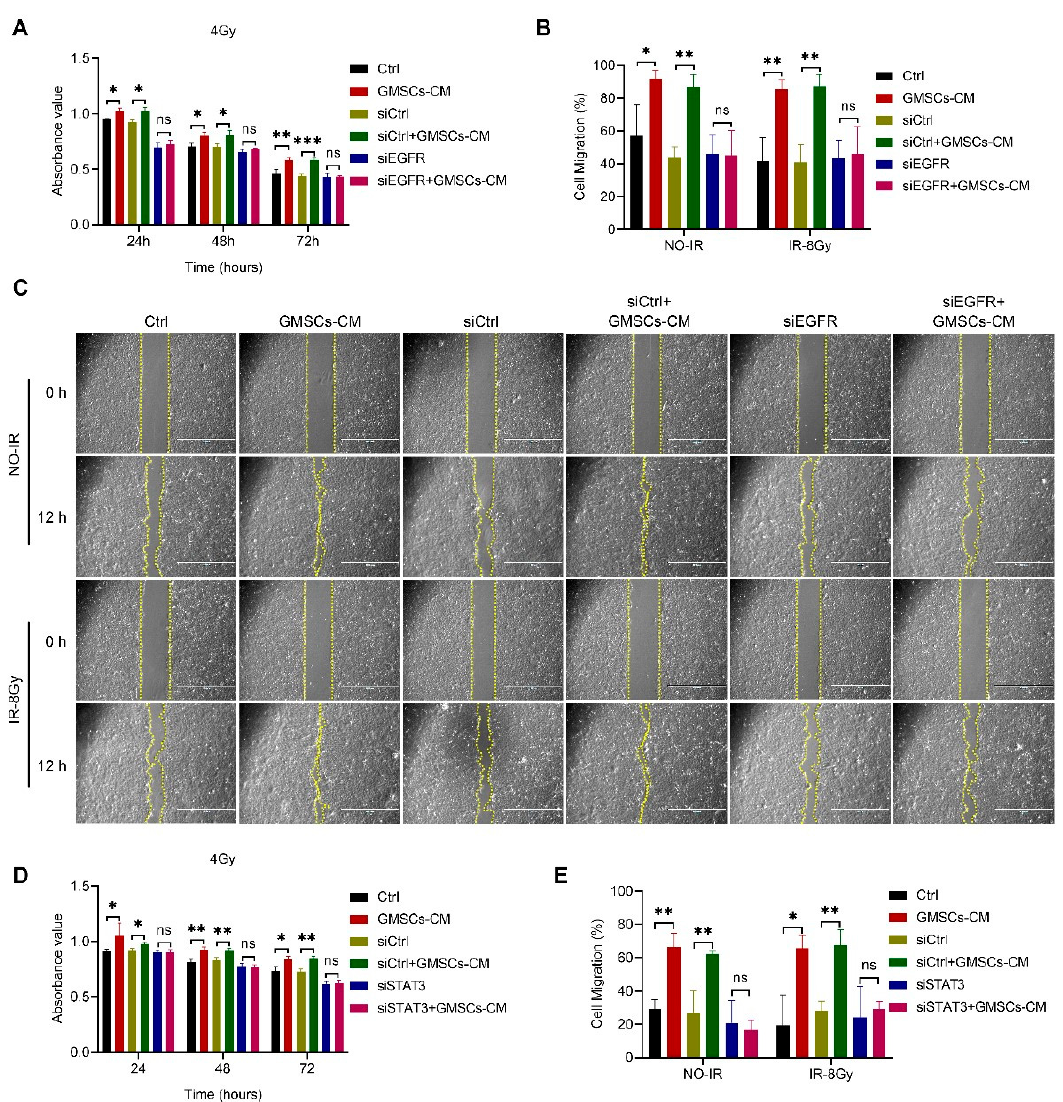
Figure 6. GMSCS-CM promoted the proliferation and migration of skin cells through the induction of phosphorylation and activation of EGFR/STAT3. ( A ) CCK-8 assay of HaCaT cell proliferation following knockdown of EGFR. ( B , C ) Evaluation of the migration ability of HaCaT cell following knockdown of EGFR by the scratch wound assay. ( D ) CCK-8 analysis of HaCaT cell proliferation following knockdown of STAT3. ( E ) Quantitative analysis of the migration rates. Scale bars, 1000 µ m. Representative results from one of three independent experiments are shown. Data are expressed as the mean ± standard deviation. Statistical comparisons were made by two-sample Student’s t -test, using the SPSS 25.0 software (IBM Corporation, Armonk, NY, USA). ns, not significant p > 0.05, * p < 0.05, ** p < 0.01 and *** p <